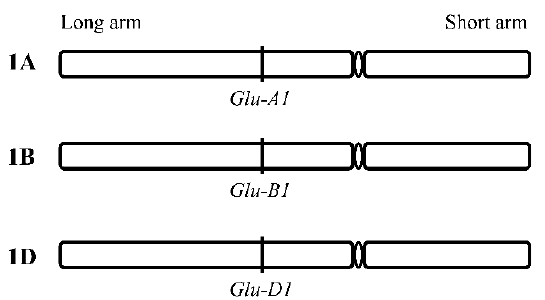
Figure 1. Schematic diagram of the gene loci of a high-molecular-weight glutenin subunit (HMW- GS) in wheat chromosome 1: the genes coding the synthesis of HMW-GS are located on the long arms of group 1 chromosomes 1A, 1B, and